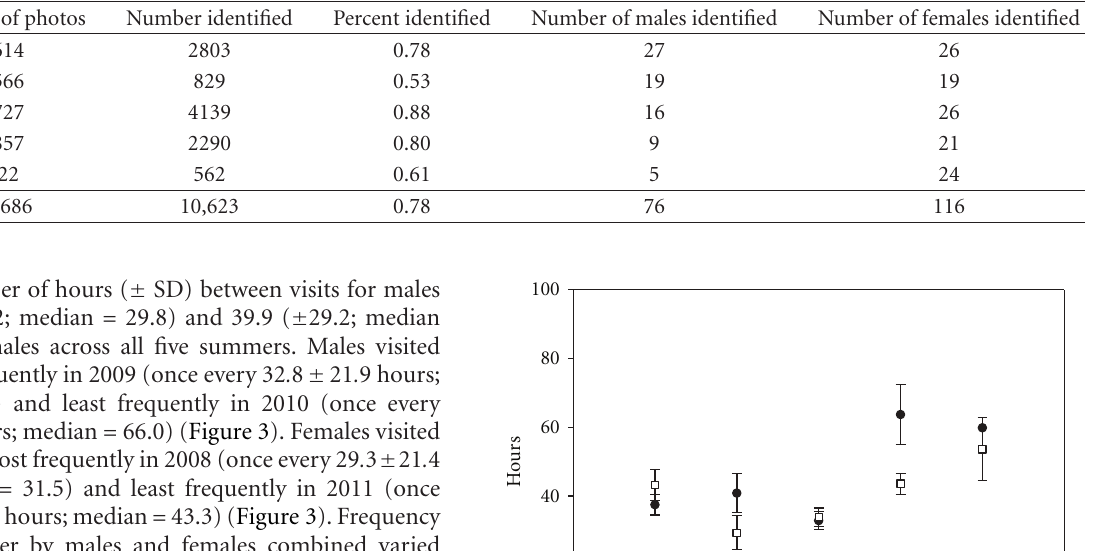
Table 2: Number of mule deer photographs taken and identified to individual, as well as the number of unique males and females detected using water sources during summer (July and August) in western Utah, USA, 2007–2011.